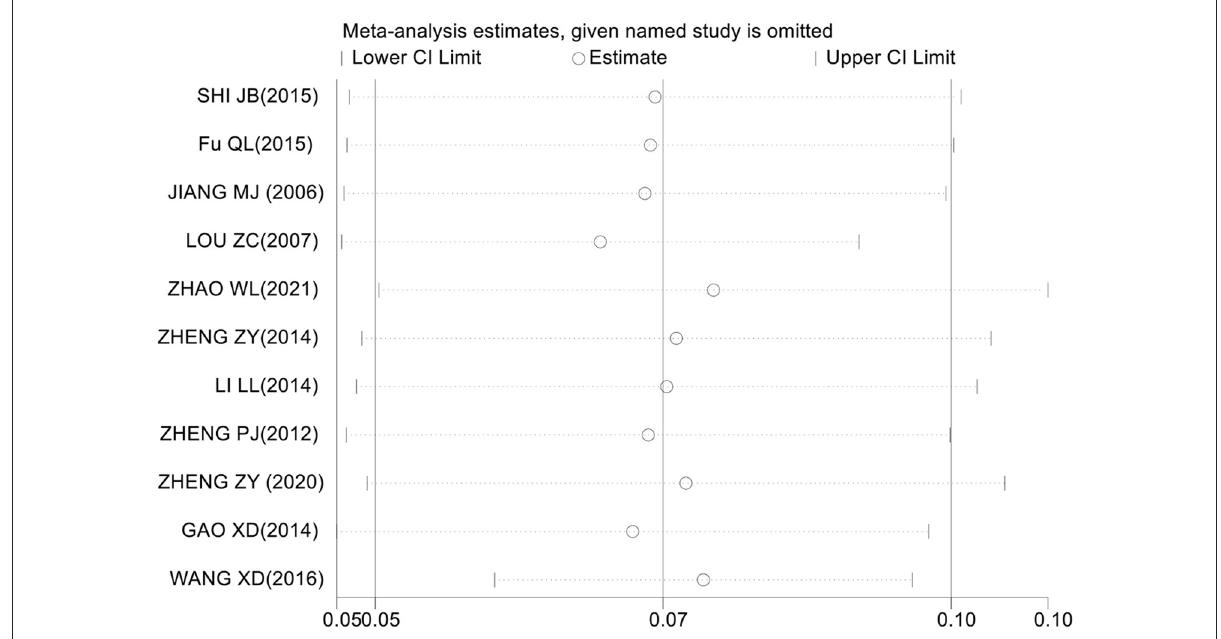
FIGURE3 The sensitivity analysis of the overall prevalence of CRS among Chinese.